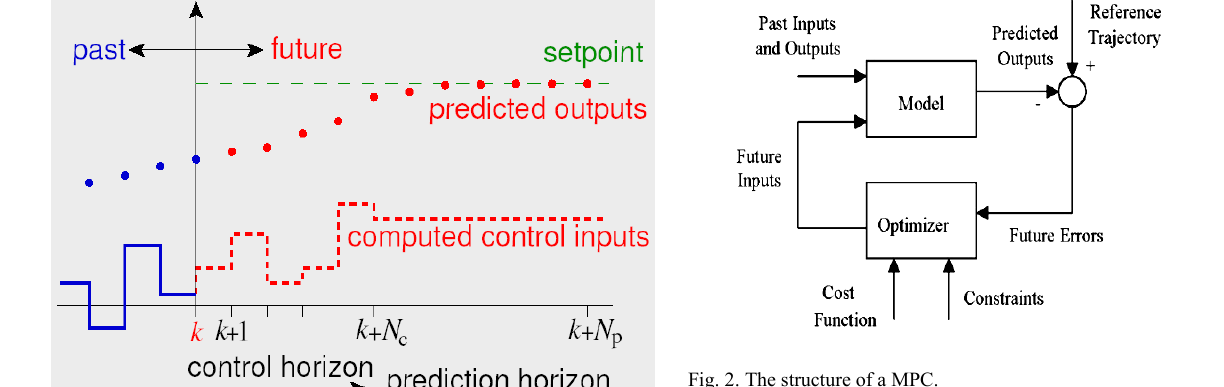
Fig. 2. The structure of a MPC.